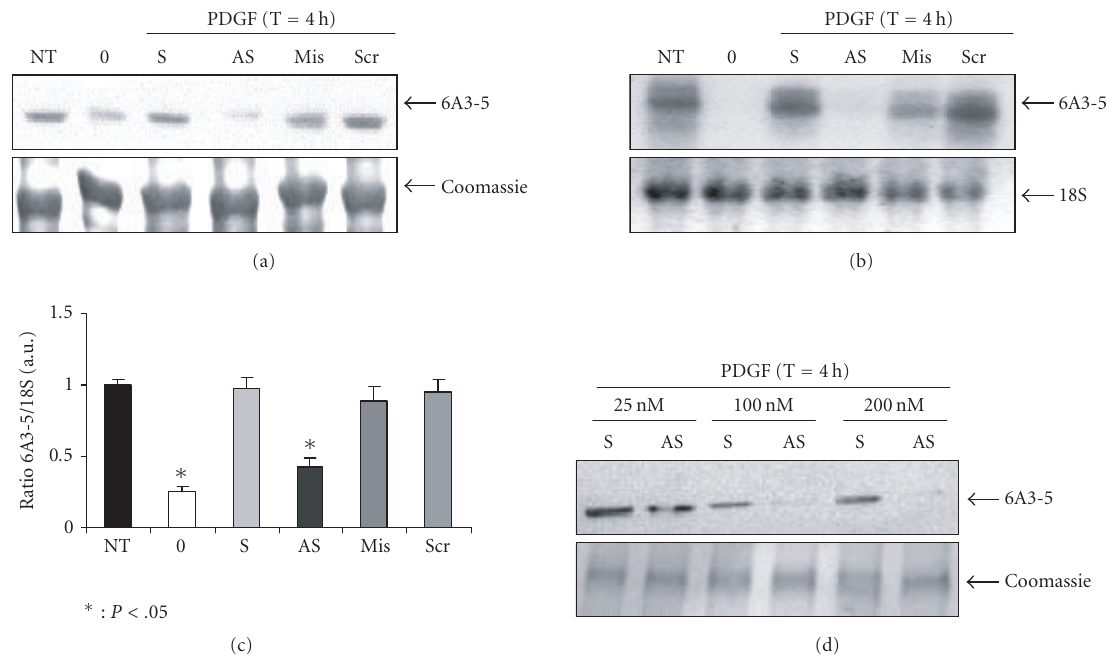
Figure 6: Inhibition of 6A3-5/Osa2 expression by ODN3 antisense. (a) Western blot of 6A3-5/Osa2 protein expression, following 4 hours of PDGF-BB stimulation. Serum starved VSMC (0) were treated, first, by 6A3-5/Osa2-ODN3 sense (S), antisense (AS), mismatched (Mis), scrambled (Scr), or vehicle (NT) at 200nM. (b) Northern blot of 6A3-5/Osa2 mRNA expression, following 4 hours of PDGF-BB stimulation. (c) Quantification of Northern blot results, which are representative of three independent experiments. (d) Western blot of 6A3-5/Osa2 protein expression, following 4 hours of PDGF-BB stimulation. Serum starved VSMC (0) were treated, first, by 6A3-5/Osa2-ODN3 sense or antisense at di ff erent concentrations (25, 100, and 200 nM).